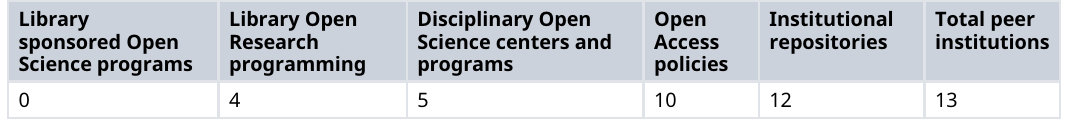
Table 2. Summary of Open Science programs at Carnegie Mellon University (CMU) ’ s peer institutions. CMU ’ s peer institutions are California Institute of Technology, Cornell University, Duke University, Emory University, Georgia Institute of Technology, Massachusetts Institute of Technology, Northwestern University, Princeton University, Rensselaer Polytechnic Institute, Rice University, Stanford University, University of